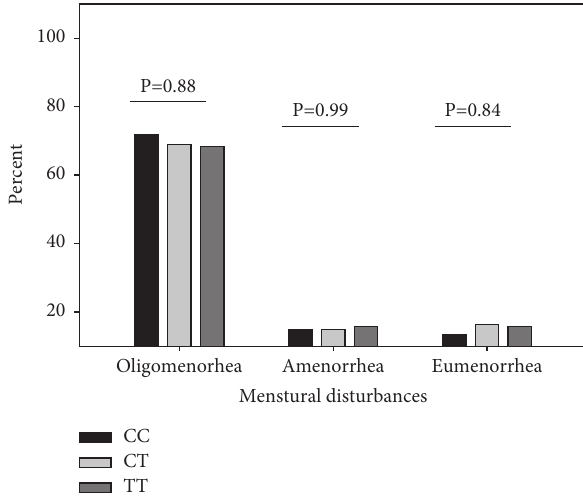
Figure 3: Comparison of the presence of menstrual disturbances, oligomenorrhea, and amenorrhea, in INSR C/T SNP genotypes in Kashmiri women with PCOS. P value of CC vs. CTvs. TTcalculated by Pearson chi-square